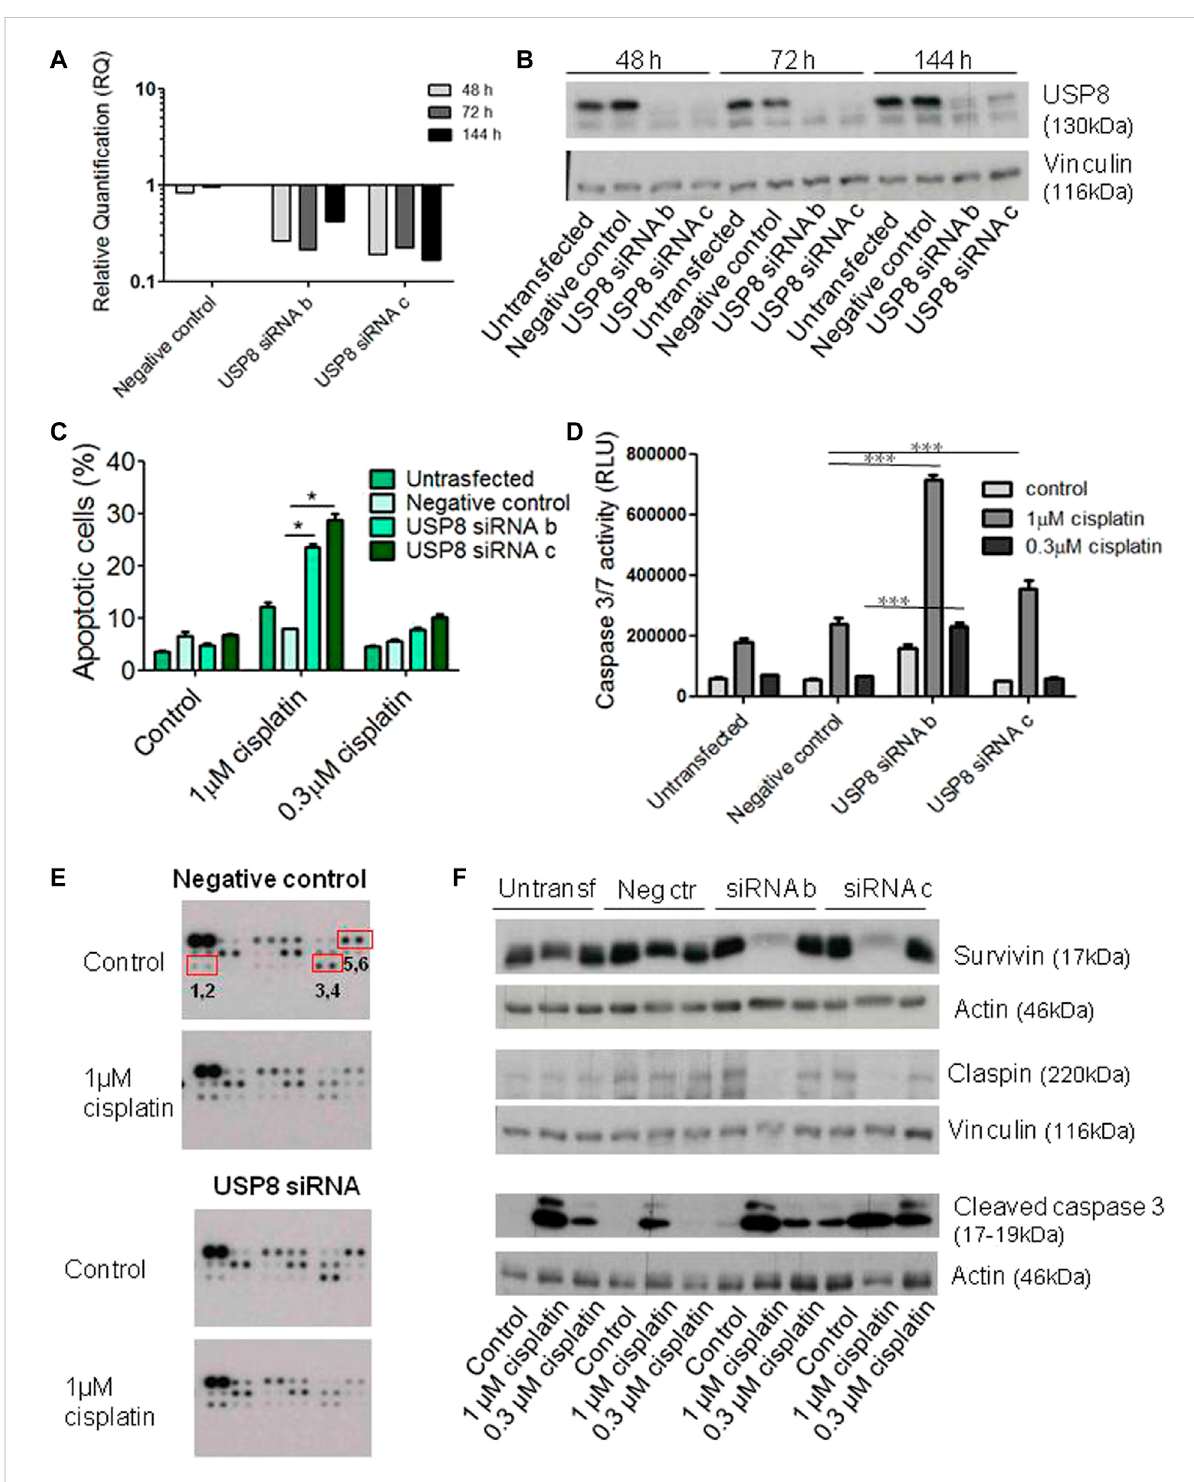
FIGURE 4 Molecular targeting of USP8 in IGROV-1 cells. (A) Quantitative RT-PCR of USP8 mRNA levels in IGROV-1 at different times after siRNA transfection; untransfected cells were used as calibrator and GAPDH as housekeeping control gene. (B) USP8 protein levels were analyzed by western blot at different times after siRNA transfection. One experiment representative of at least three is reported. Control loading is shown by vinculin. The band intensity was quanti fi ed using ImageJ, normalized to vinculin and the obtained values are reported in the